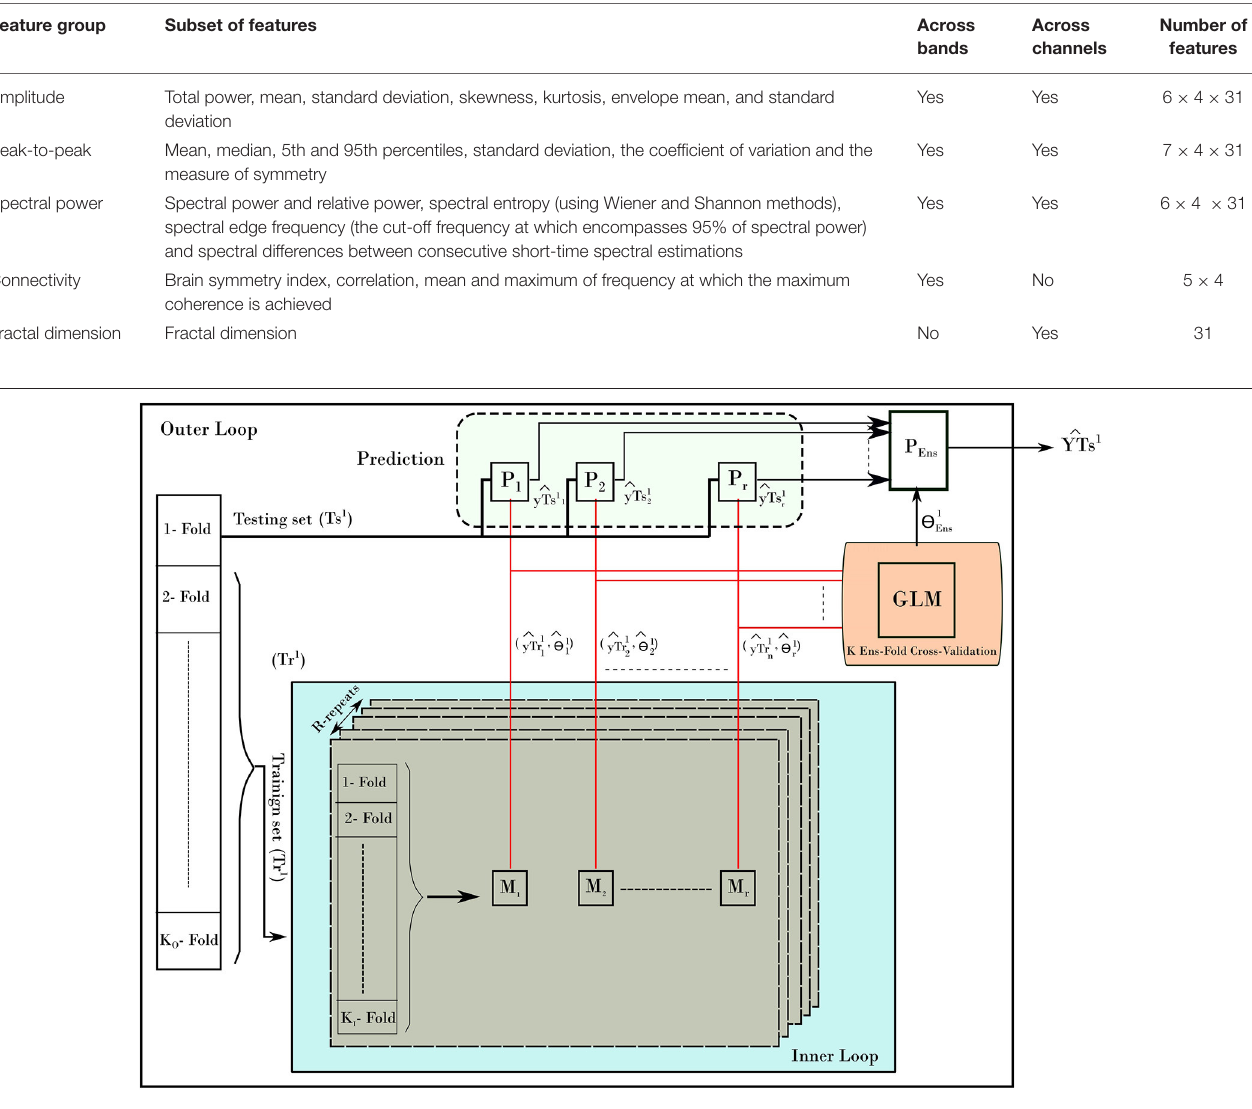
Across bands channels